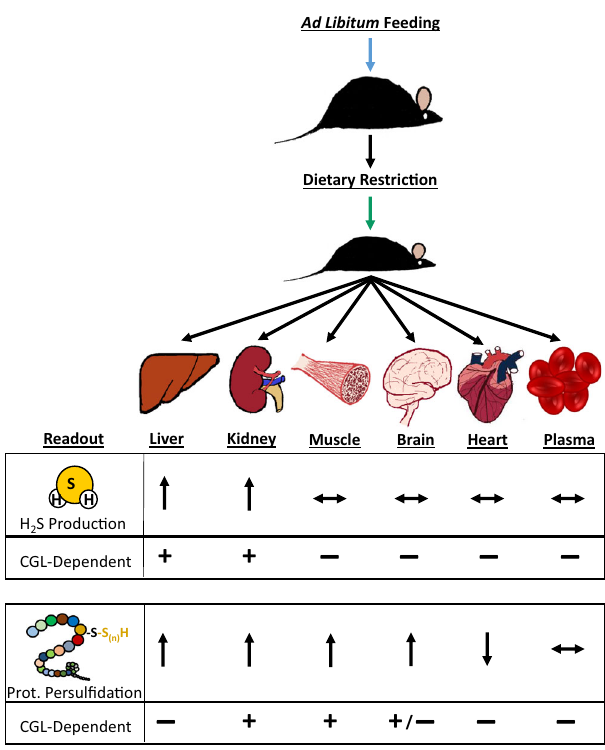
Fig. 10 Model depicting the impact of dietary restriction (DR) on endogenous H 2 S production and protein persul fi dation in tissue-speci fi c and CGL-dependent manners. Arrows pointing up indicate an increase, arrows pointing down indicate a decrease, horizontal arrows indicate no change, and + or − relate to CGL dependence for the indicated DR-induced changes relative to ad libitum fed